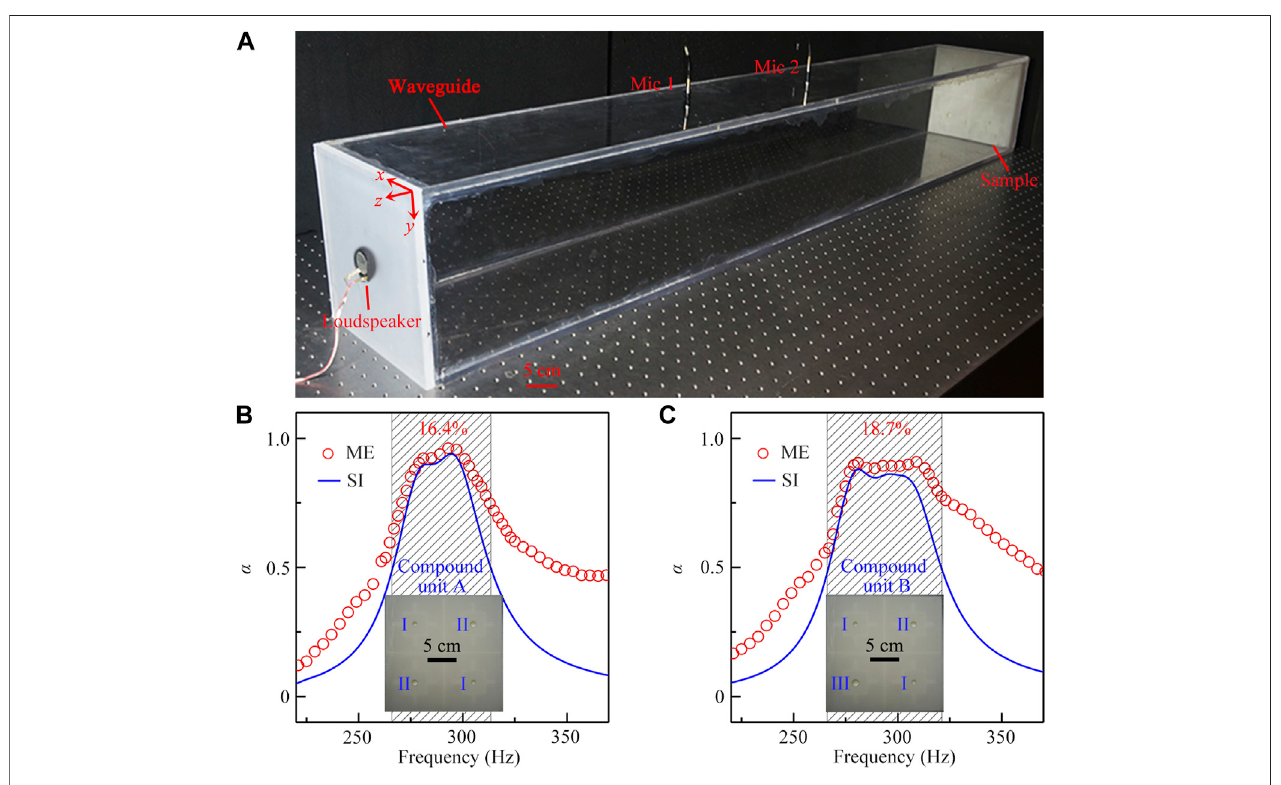
FIGURE 5 | (A) Experiment set-up of sound absorption for the compound unit. Simulated (blue solid lines) and measured (red open circles) sound absorption spectra of the compound units (B) A and (C) B. The arrangement of 4 units with different values of d ( d (cid:1) 8, 10, and 12 mm for the units I, II, and III) are shown in the paragraphs of the compound units A and B (shown as two insets on the